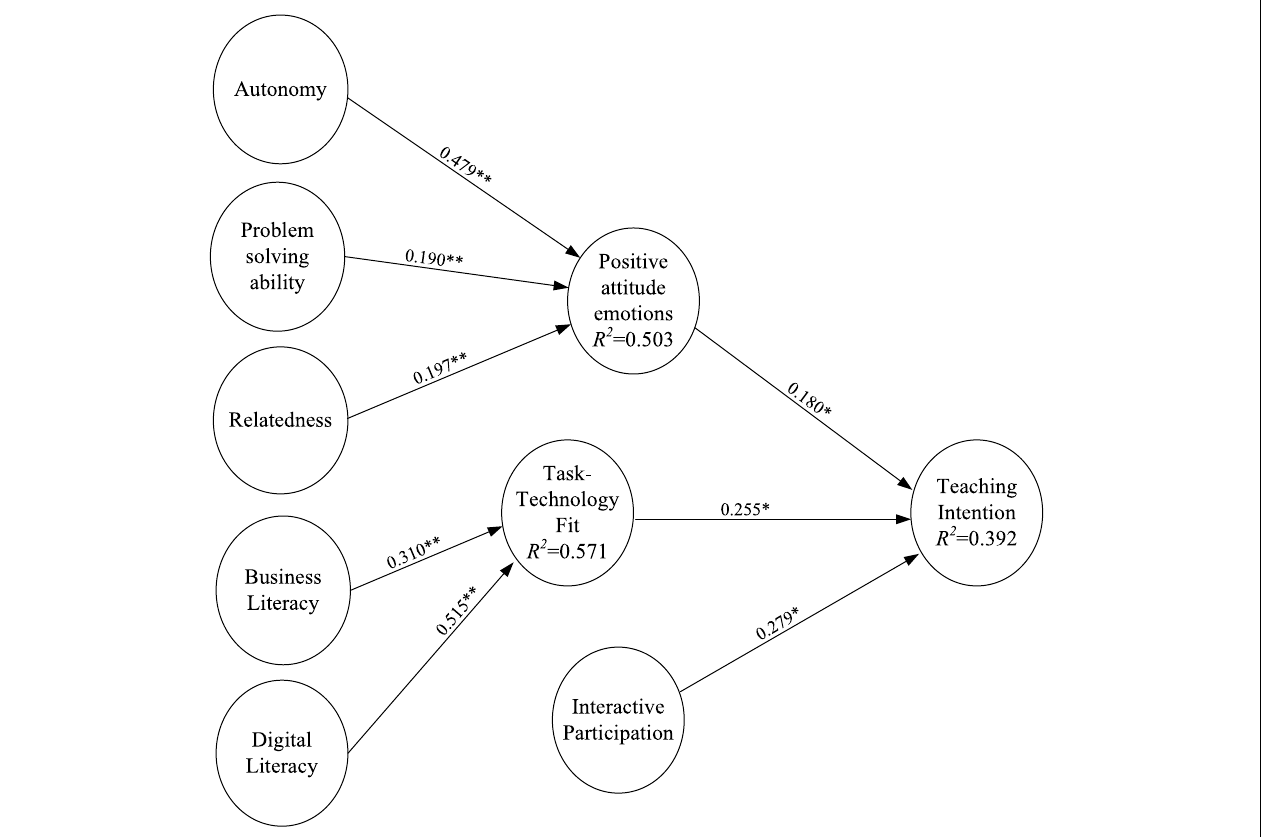
FIGURE 2 | Results of the structural model testing. Value on path, standardized coefficients ( β ); R 2 , coefficient of determination. ∗ p < 0.05; ∗∗ p < 0.01.